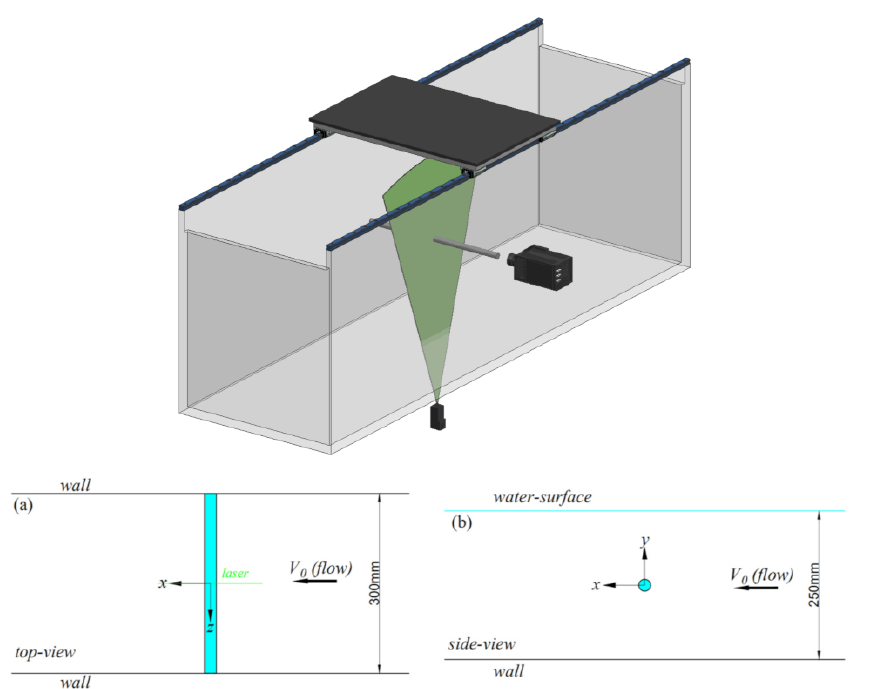
Figure 3. The installation location of the experimental cylinders: ( a ) top-view, ( b )